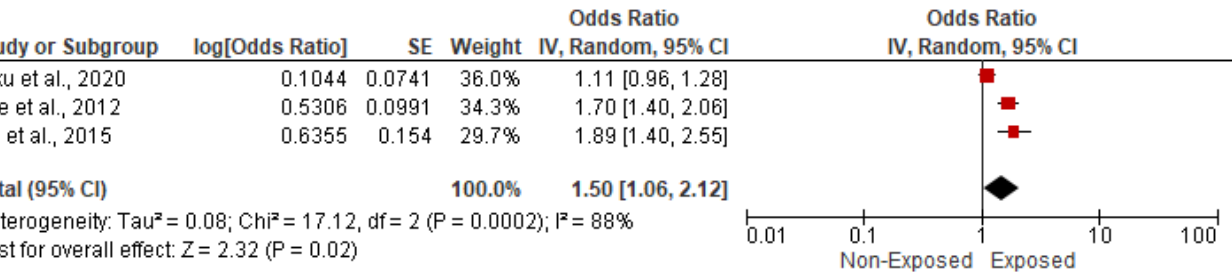
Figure 12. Forest plot of summary analysis of the Odds ratio and 95% CI of the association between HAP and heart failure. The size of the red squares is proportional to the statistical weight of each trial. The gray diamond represents the pooled point estimate. The positioning of both diamonds and squares (along with 95% CIs) beyond the vertical line (unit value) suggests a significant out- come (IV = inverse variance).